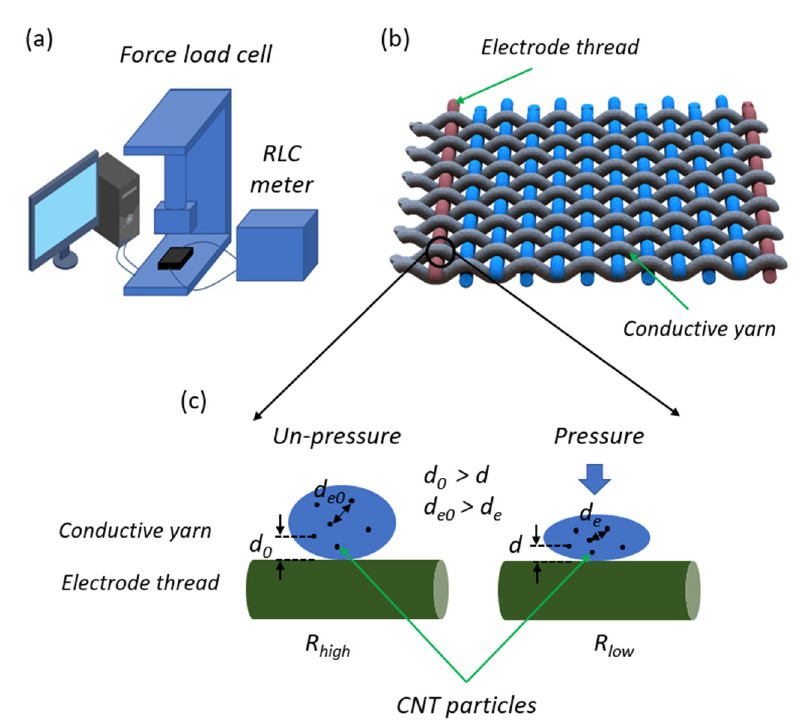
Figure 3. ( a ) Universal tensile machine (UTM), ( b ) sensing layer, and ( c ) working